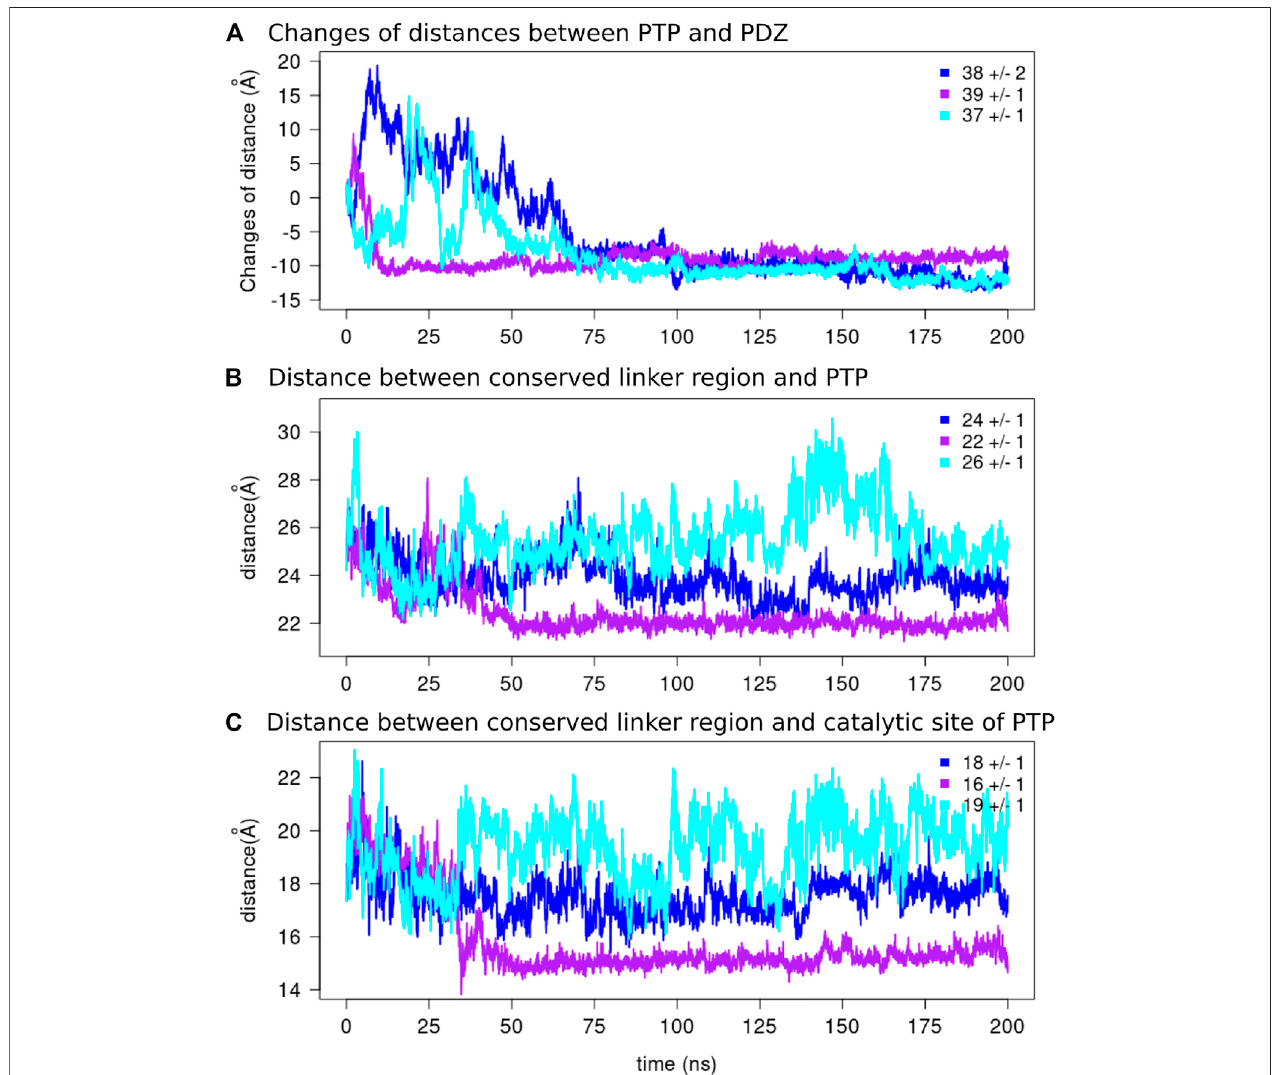
FIGURE 8 | The distances along the MD simulations. (A) The changes of distances between the two domains and the average values over the fi nal 125 ns of the simulationsarereported foreach replicate. Thedistancebetweenthecenterofmassofthe conserved linker region[E (617)PDFQYIP(624)] andthecenterofmassof (B) the PTP domain and (C) the catalytic site of the PTP domain are depicted for each